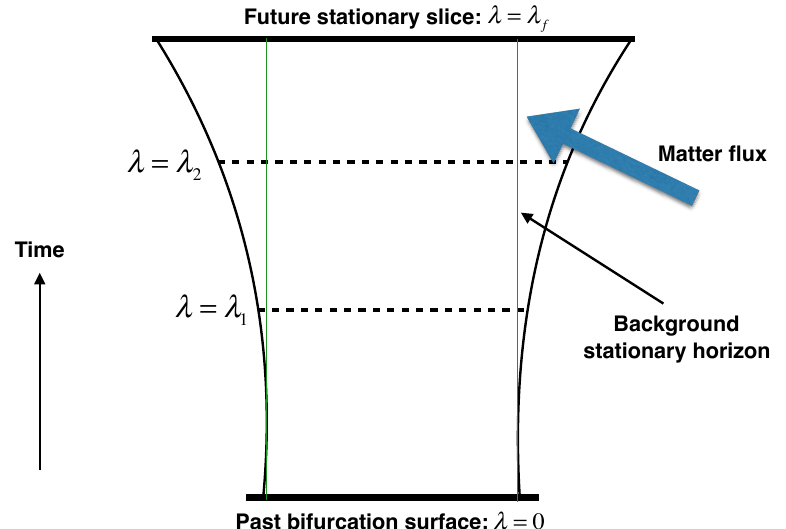
Figure 1 . A pictorial depiction of the geometry considered in the Physical process version of the (cid:12)rst law. The green line depicts the evolution of the unperturbed stationary event horizon while the black curve denotes the evolution of the perturbed dynamical event horizon. The change in area is calculated between the two slices (cid:21) = 0 (the bifurcation surface) and (cid:21) = (cid:21) f (a stationary (cid:12)nal slice) along the black curve. We would like to generalize this and calculate the change between two arbitrary slices (cid:21) = (cid:21) 1 and (cid:21) = (cid:21) 2